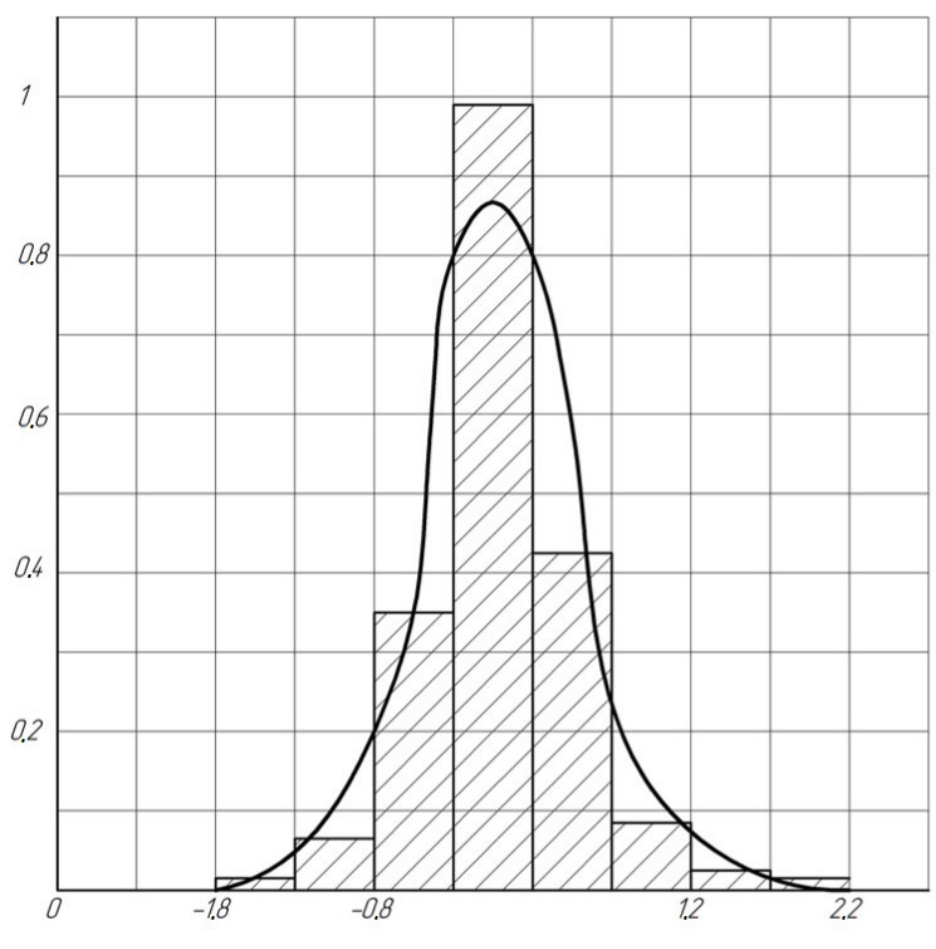
Figure 2. Histogram for evaluation j ∗